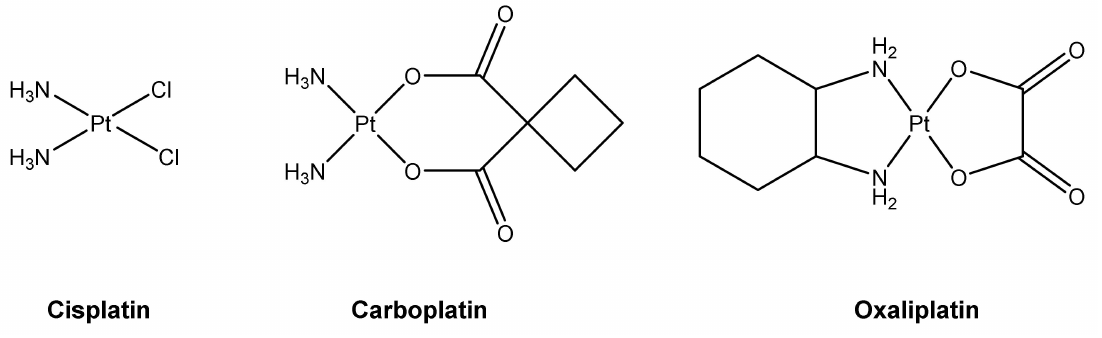
Figure 1. Structures of the clinically approved platinum-based anticancer drugs cisplatin, carboplatin and